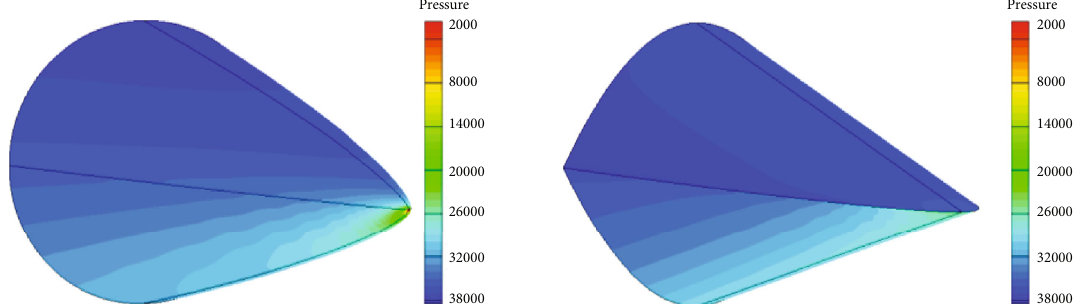
Figure 12: The surface static pressure distribution of the two con fi gurations.